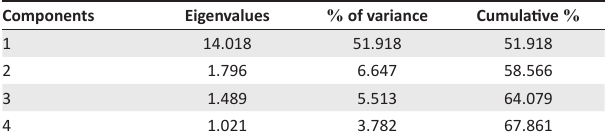
TABLE 2: Total variance explained.